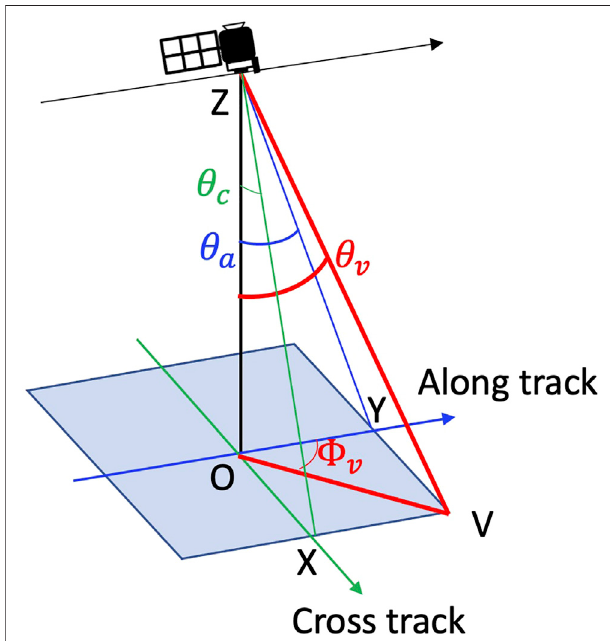
FIGURE2| TheobservinggeometryoftheinstrumentatZ.Thedirection to an arbitrary location on the ground V can be determined by the along-track (OX direction) zenith angles θ a , and the cross-track (OY direction) zenith angle θ c .Theviewingzenithandazimuthangles( θ θ a and c as shown in Eqs 16 , 17